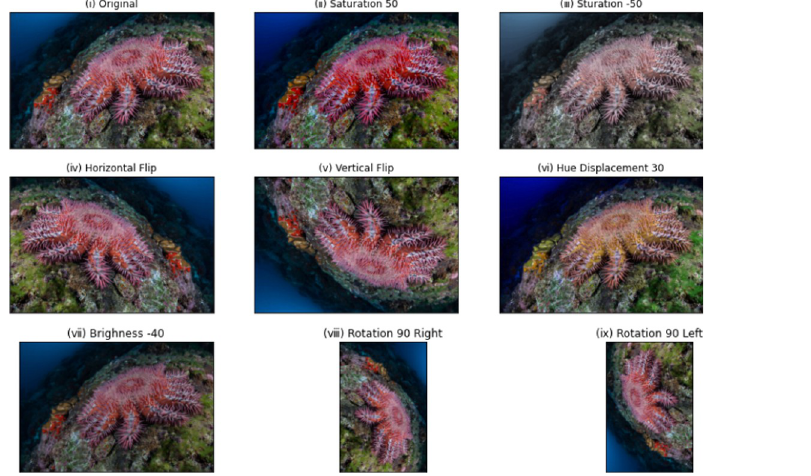
Fig 10. Images after the application of data